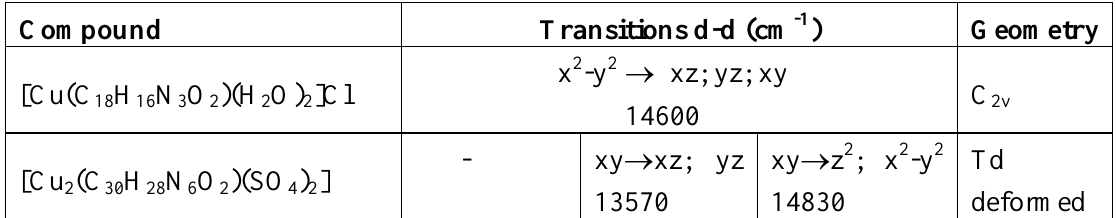
Table 2 . Electronic spectra of the synthesized complex